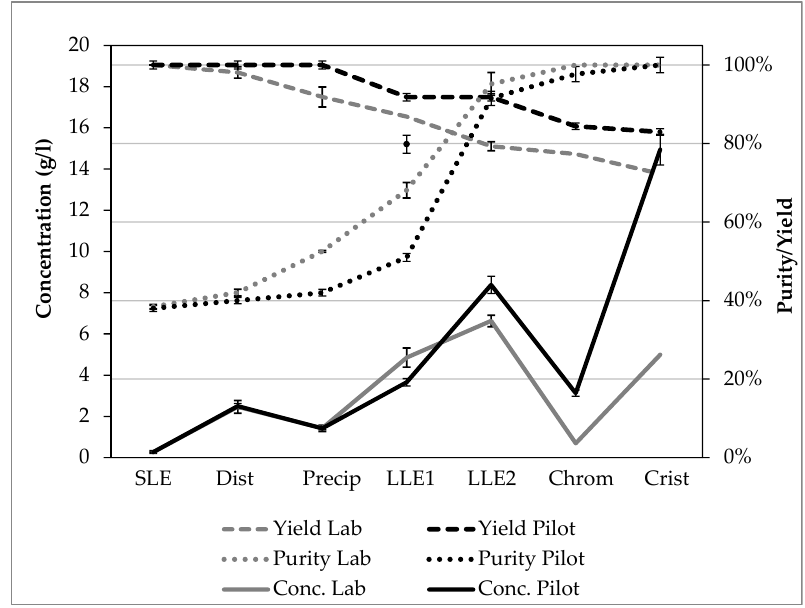
Figure 4. Overview of the process design (Conc., concentration).